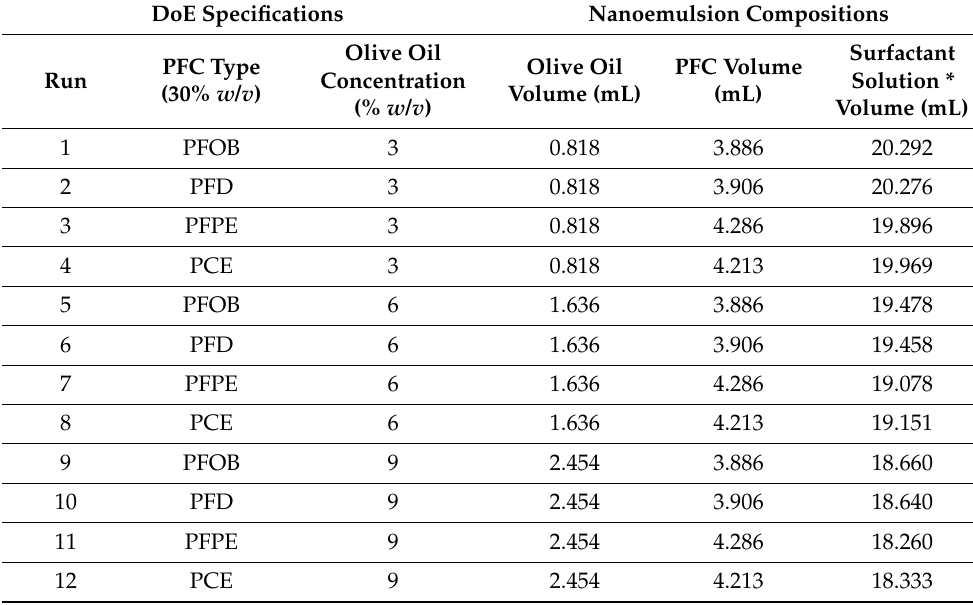
Table 4. Summary of study design (left columns) and resulting nanoemulsion compositions (right columns). A full factorial design of experiments was developed to study the impact of perfluorocarbon type and olive oil concentration on nanoemulsion colloidal and fluorescent stability. * Surfactant solution is 3% w / v Cremophor EL and 2% w / v pluronic P105 in